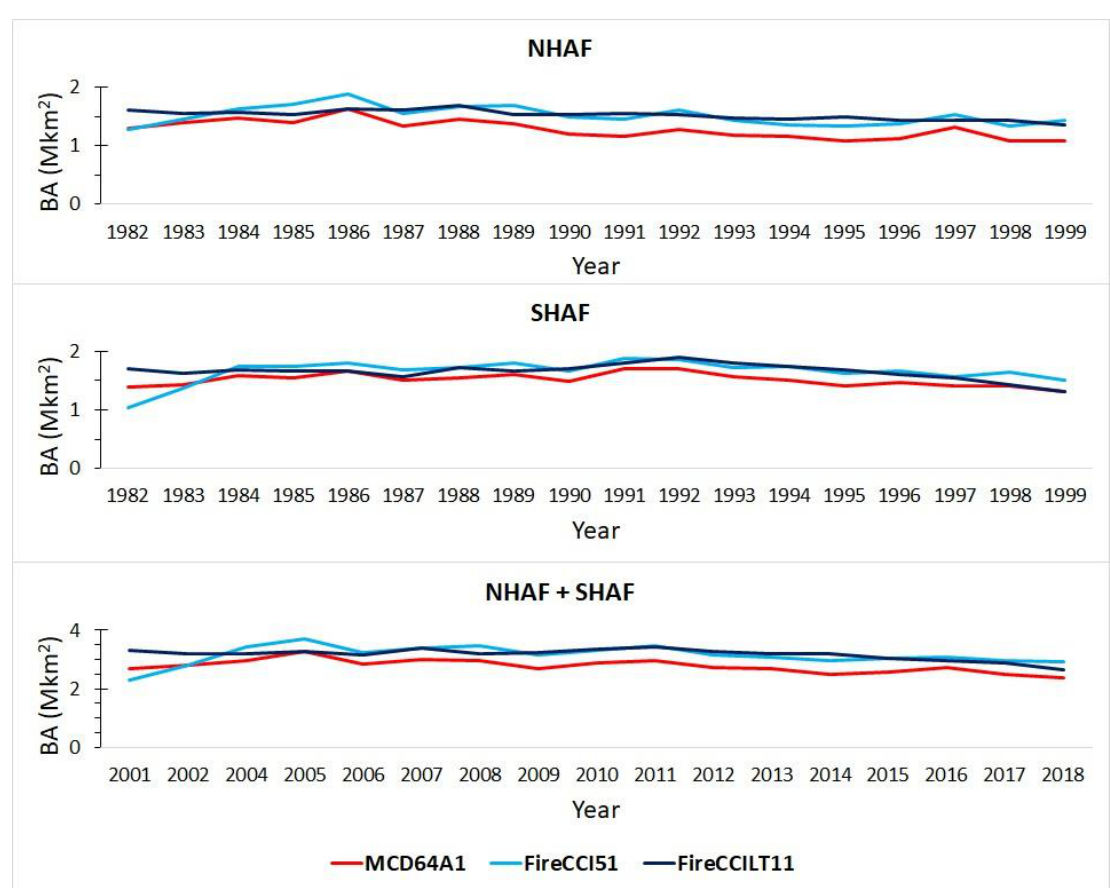
Figure 2. Annual BA trends of MCD64A1, FireCCI51 and FireCCILT11 in the different African regions.